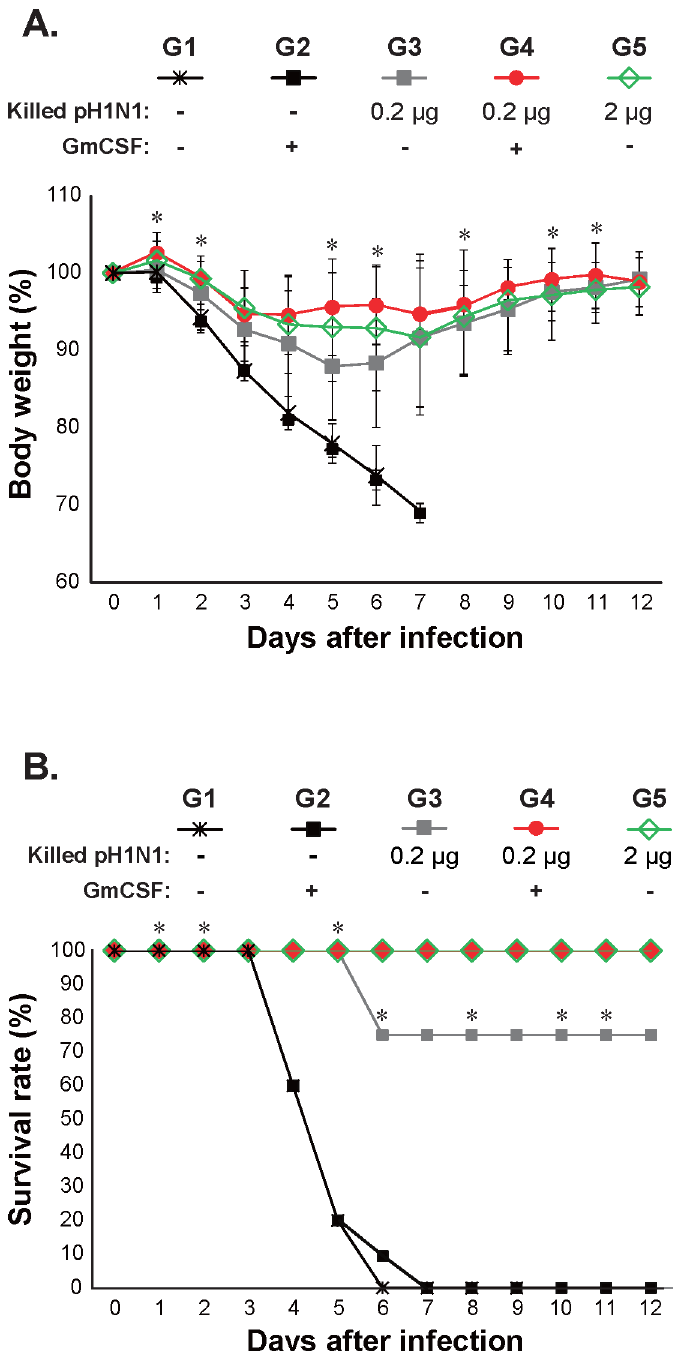
Fig 6. Protective effect of immunization against challenge with a lethal dose of ma-pH1N1. The body weight of mice intranasally challenged with a 10LD 50 dose of mouse-adapted influenza virus (ma-pH1N1) 4 weeks after the final immunization was monitored for 12 consecutive days. (A) Percentage body weight change after challenge with a 10LD 50 dose of mouse-adapted influenza virus (ma-pH1N1). Changes in body weight (n = 9 mice/group) are expressed as the mean ± SD for each group. (B) Survival rate after challenge with a 10LD 50 dose of mouse-adapted influenza virus (ma-pH1N1). Crosses, mice injected with PBS; black squares, mice vaccinated with AcHERV-GmCSF; gray squares, mice vaccinated with 0.2 μ g of killed vaccine; red circles, mice vaccinated with 0.2 μ g of killed vaccine together with AcHERV-GmCSF; open green diamonds, mice vaccinated with 2 μ g of killed vaccine. Statistical analysis performed between